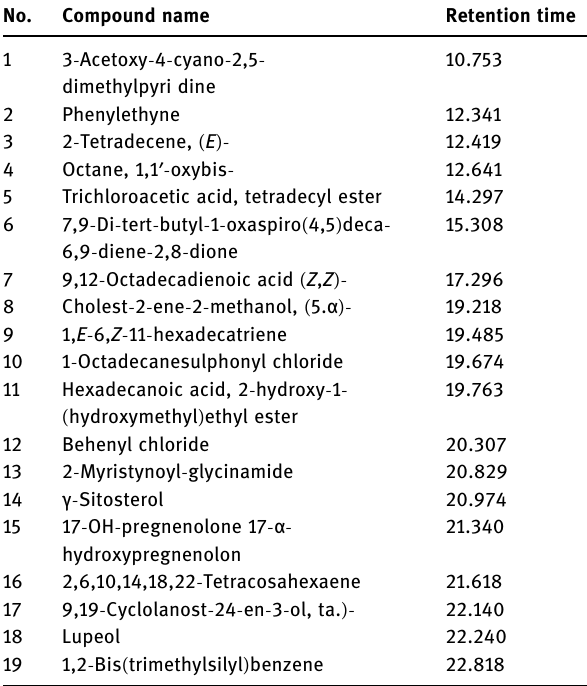
Table 3: GC - MS analysis of B. monnieri